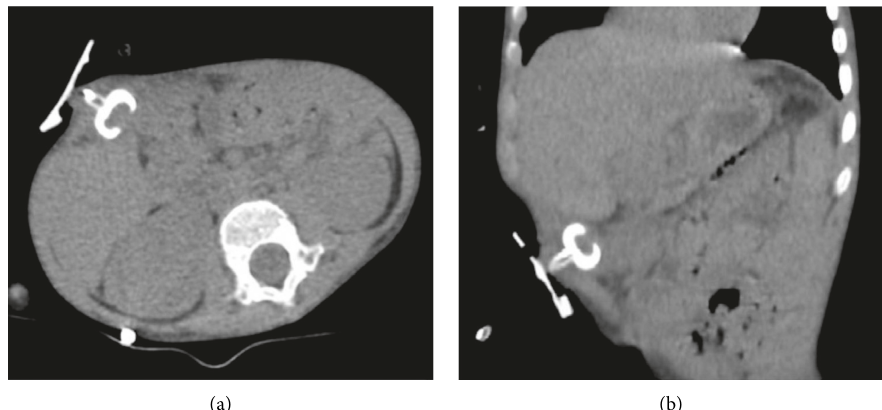
Figure 1: In transverse cut (a) and coronal cut (b) of CTexam, the gastrostomy tube was correctly positioned in the gastric antrum pulled to the